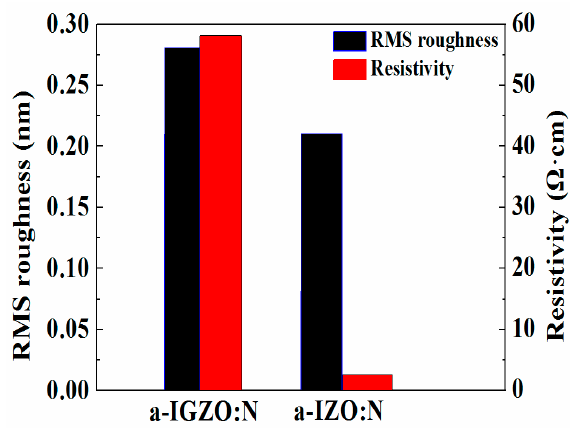
Figure 3. Root mean square (RMS) roughness and resistivity of a-IGZO:N and a-IZO:N thin films.